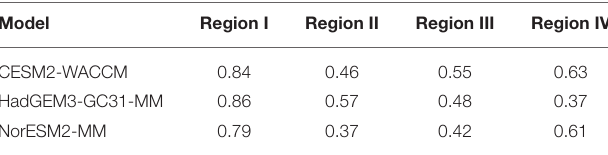
TABLE 2 | The temporal correlation coefficients of near-surface wind speeds during 1979 to 2014 over the four regions between ERA5 and three CMIP6 historical